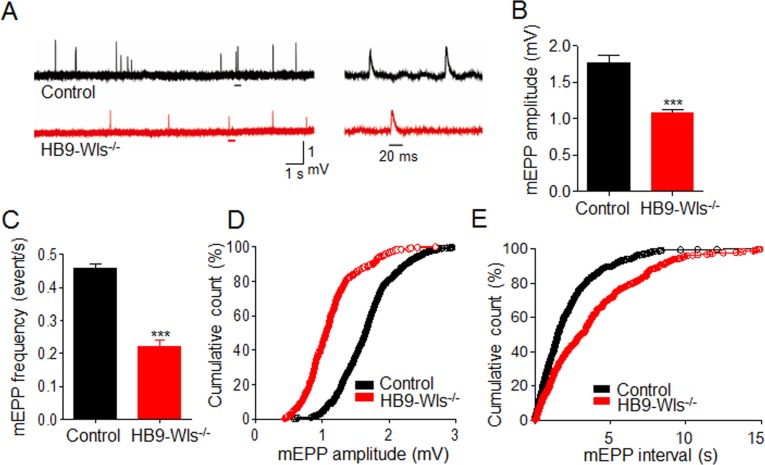
Impairment of pre- and postsynaptic prosperity in P15 HB9-Wls-/- mice.(A) Representative mEPP traces from P15 mice. mEPPs were recorded from hemidiaphragms. Traces underlined on the left are enlarged on the right. (B) Reduced mEPP amplitudes in diaphragms of HB9-Wls-/- mice at P15. n = 4 mice per group, 5–6 muscle fibers per mouse; Unpaired t-test, ***p<0.001. (C) Reduced mEPP frequencies in in diaphragms of HB9-Wls-/- mice at P15. ***p<0.001. n = 4 mice per group, 5–6 muscle fibers per mouse; Unpaired t-test, ***p<0.001. (D) Cumulative plots of mEPP events against amplitudes. (E) Cumulative plots of mEPP events intervals.